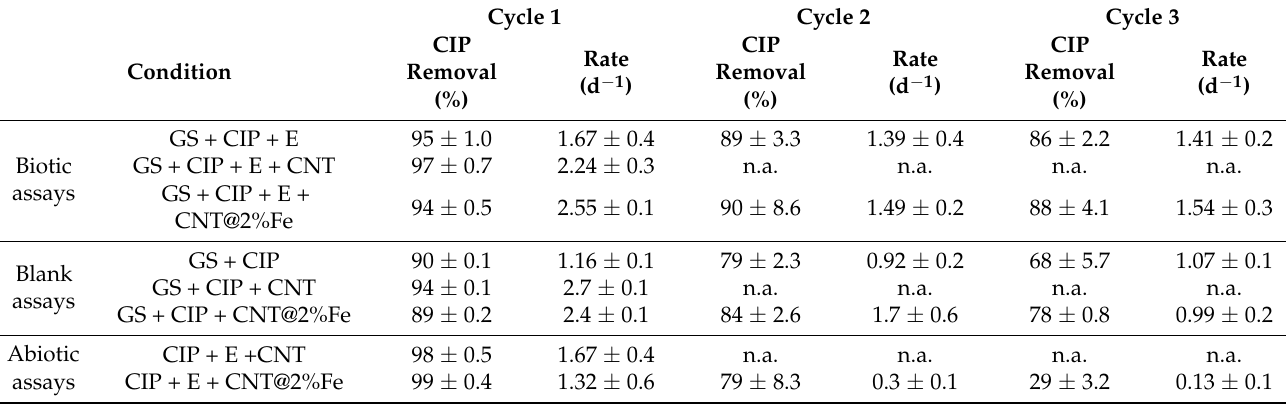
Table 3. Percentage of CIP removal (%) and rate (d − 1 ) in the anaerobic assays, performed in the absence and presence of CNM. Blank controls without ethanol, as well as abiotic assays without granular sludge are also